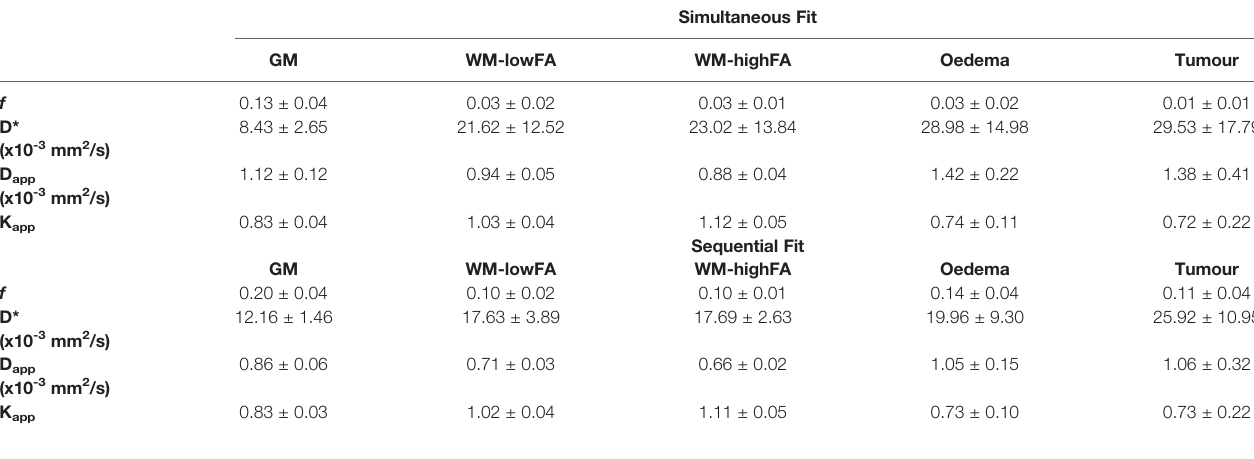
TABLE 1 | Subject level averages for the tissue class fi tting routines to the IVIM/NG-diff model (Eq. 13). Signi fi cant differences between the fi ts are found in f and D app in all the classes, and in D * in GM, (p-value <